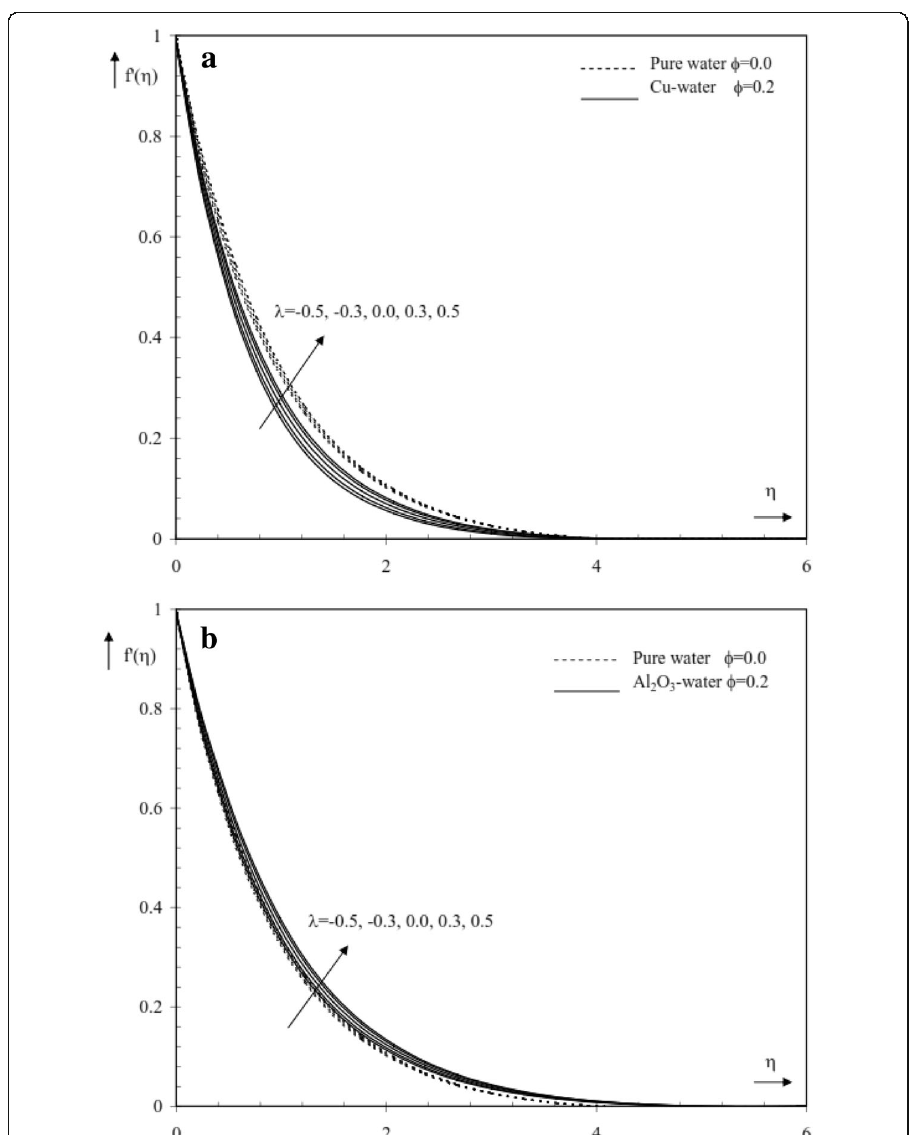
Fig. 13 Effects of ϕ and λ on velocity distribution f ′ ( η ) for S = M = f w = 0.1 and A = B = 0.5 for a Cu-water and b Al 2 O 3